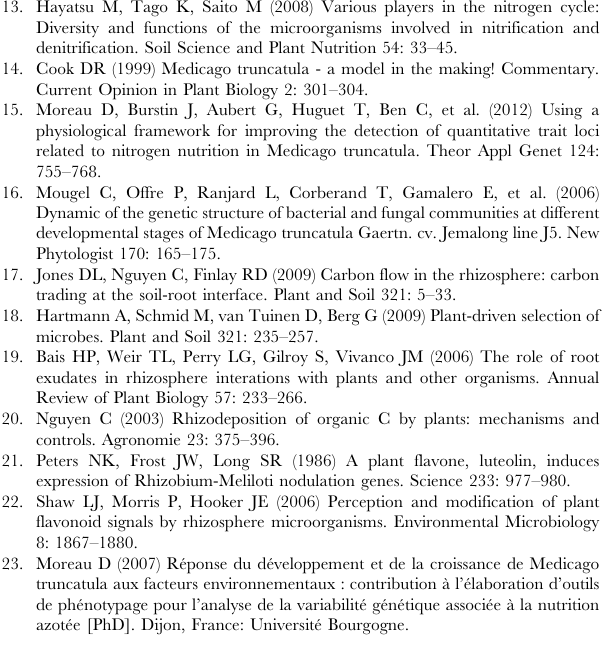
Table S1 Level of symbiotic association for different genotypes of Medicago truncatula and N treatments. a Intensity of nodulation was visually assessed at 934 degree-days after sowing, using a qualitative scale (Moreau et al. 2008). The scale includes five scores: 0 (absence of nodules), 1 (only some white nodules of small size), 2 (both white and pink nodules of small size), 3 (mainly pink nodules of larger size), and 4 (many pink nodules of large size). b Mycorrhization parameters represented the frequency (F%) and intensity of colonisation of the root cortex